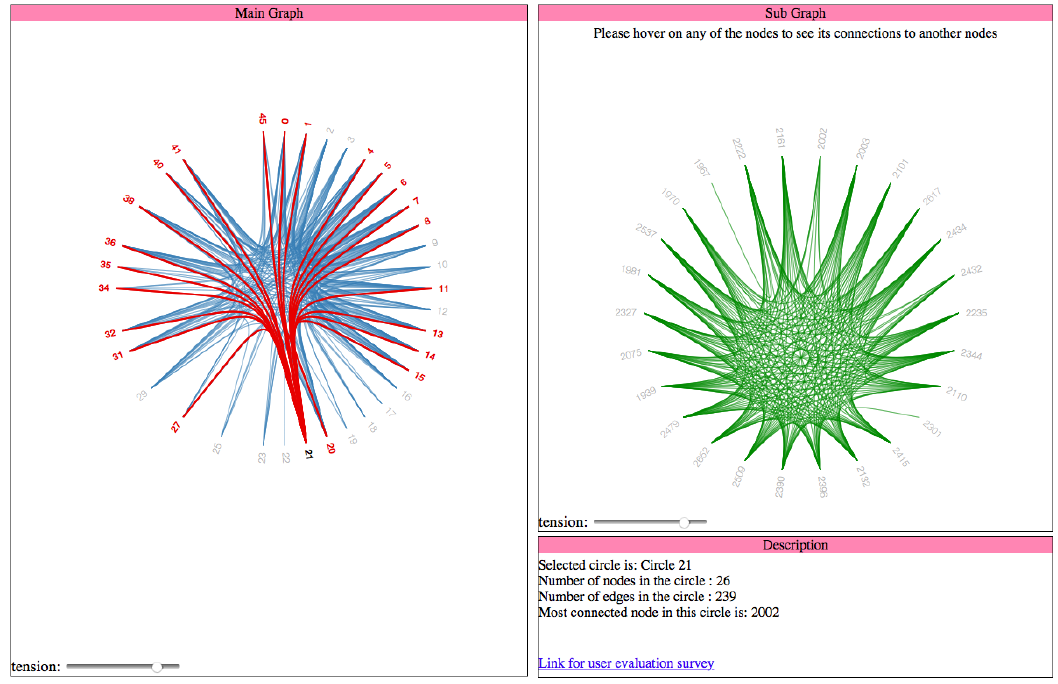
Figure 10. User interface for visualization using hierarchical edge bundling for both main and sub